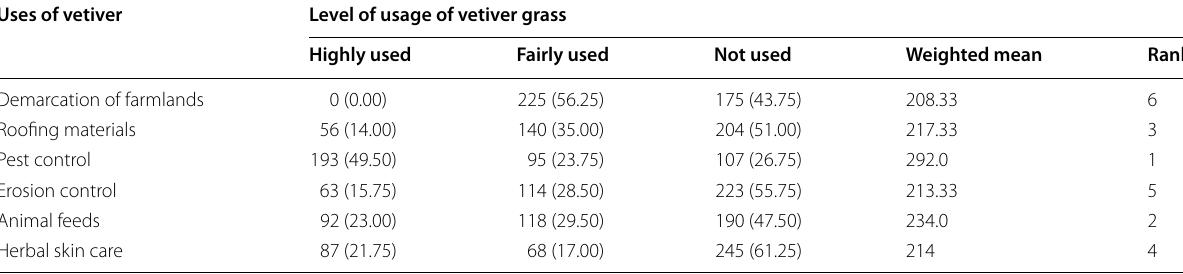
Figures in parenthesis are percentage